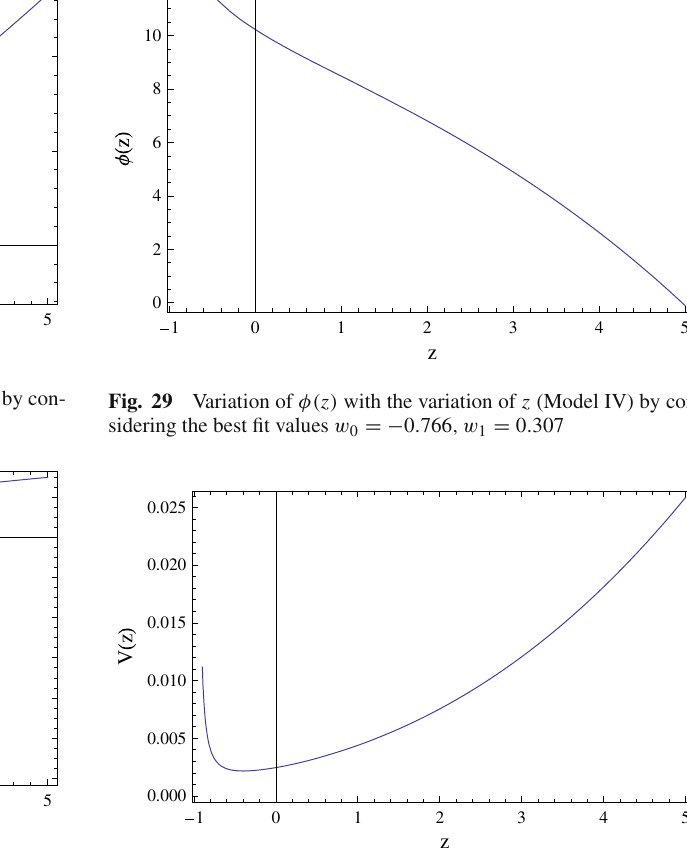
= 7 . 088 and the best fit the minimum value of χ 2 Tot values of the parameters w 0 = − 0 . 755 and w 1 = 0 . 262 where we have fixed the other parameters β = = − 0 . 3 , ω = 0 . 2 , v = 0 . 5 , f = − 0 . 5 , D = 5 , w m 0 0 2 , n = 3 , (cid:13) m 0 = 0 . 3 , (cid:13) k 0 = 0 . 05 and H 0 = 72 km s − 1 MPc − 1 . We have plotted the contours of ( w 0 , w 1 ) in Fig. 17 for different confidence levels 66% (solid, blue), 90% (dashed, red) and 99% (dashed, black). Now